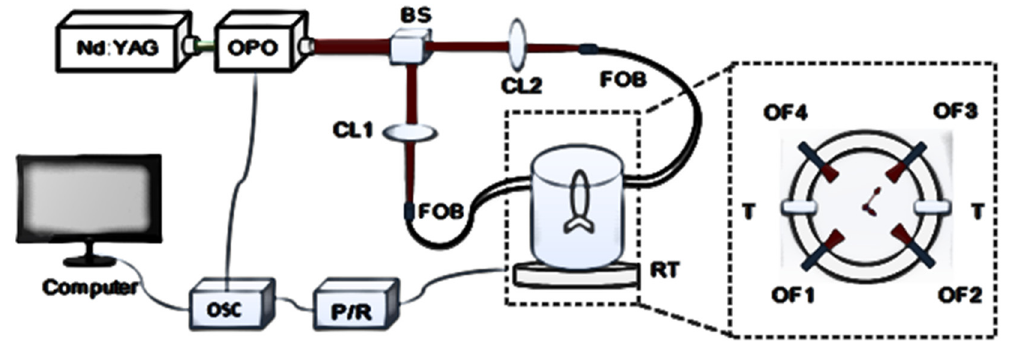
Figure 1. Experimental configuration of the photoacoustic tomography (PAT) system. OPO: Optical Parametric Oscillator; OSC: Oscilloscope; P/R: Pulser/Receiver; BS: Beam Splitter; CL: Convex Lens; FOB: Fiber Optics bundle; RT: Rotary Table; T: Transducer; OF: Optical Fiber.